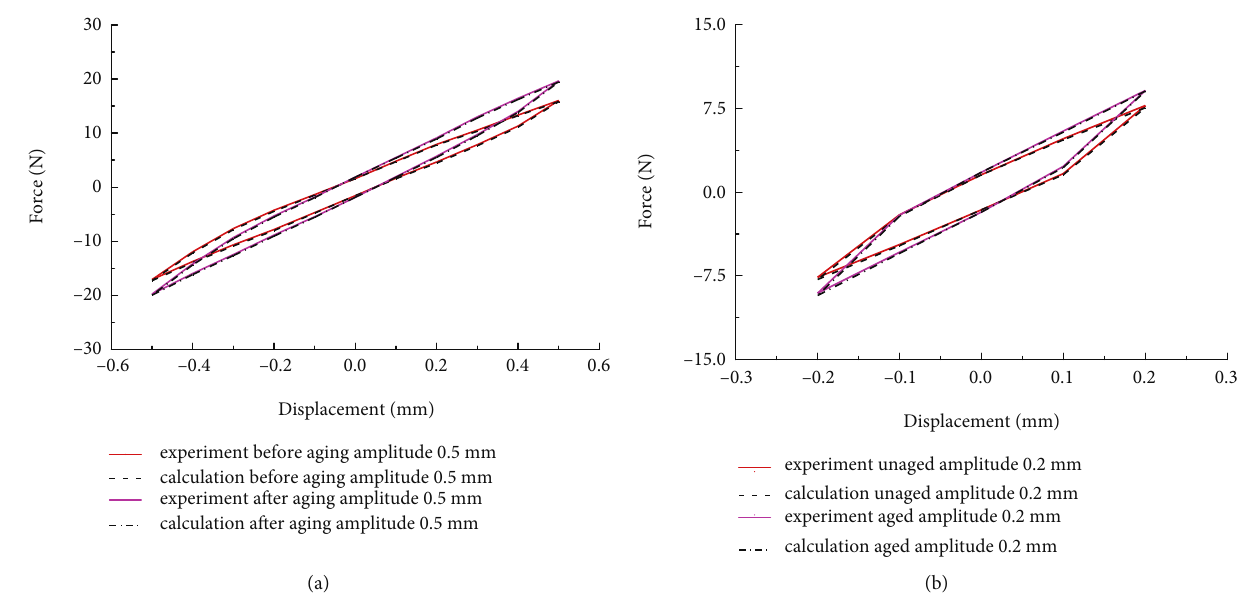
Figure 15: Hysteresis loops under the amplitudes of 0.2 and 0.5 mm. (a) Hysteresis loops under the amplitude of 0.5mm, and (b) hysteresis loops under the amplitude of 0.2mm.